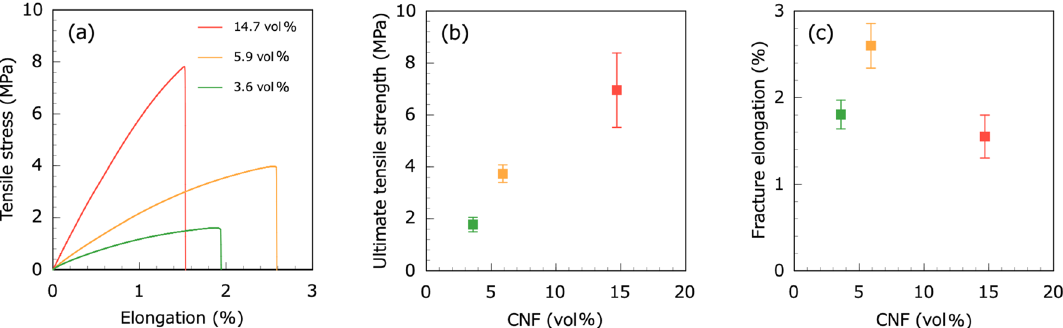
Figure 8. ( a ) Stress-elongation curves of the CNF–CoFe 2 O 4 composite papers; plots of ( b ) UTS and ( c ) fracture elongation versus CNF volume fraction in the CNF–CoFe 2 O 4 composite